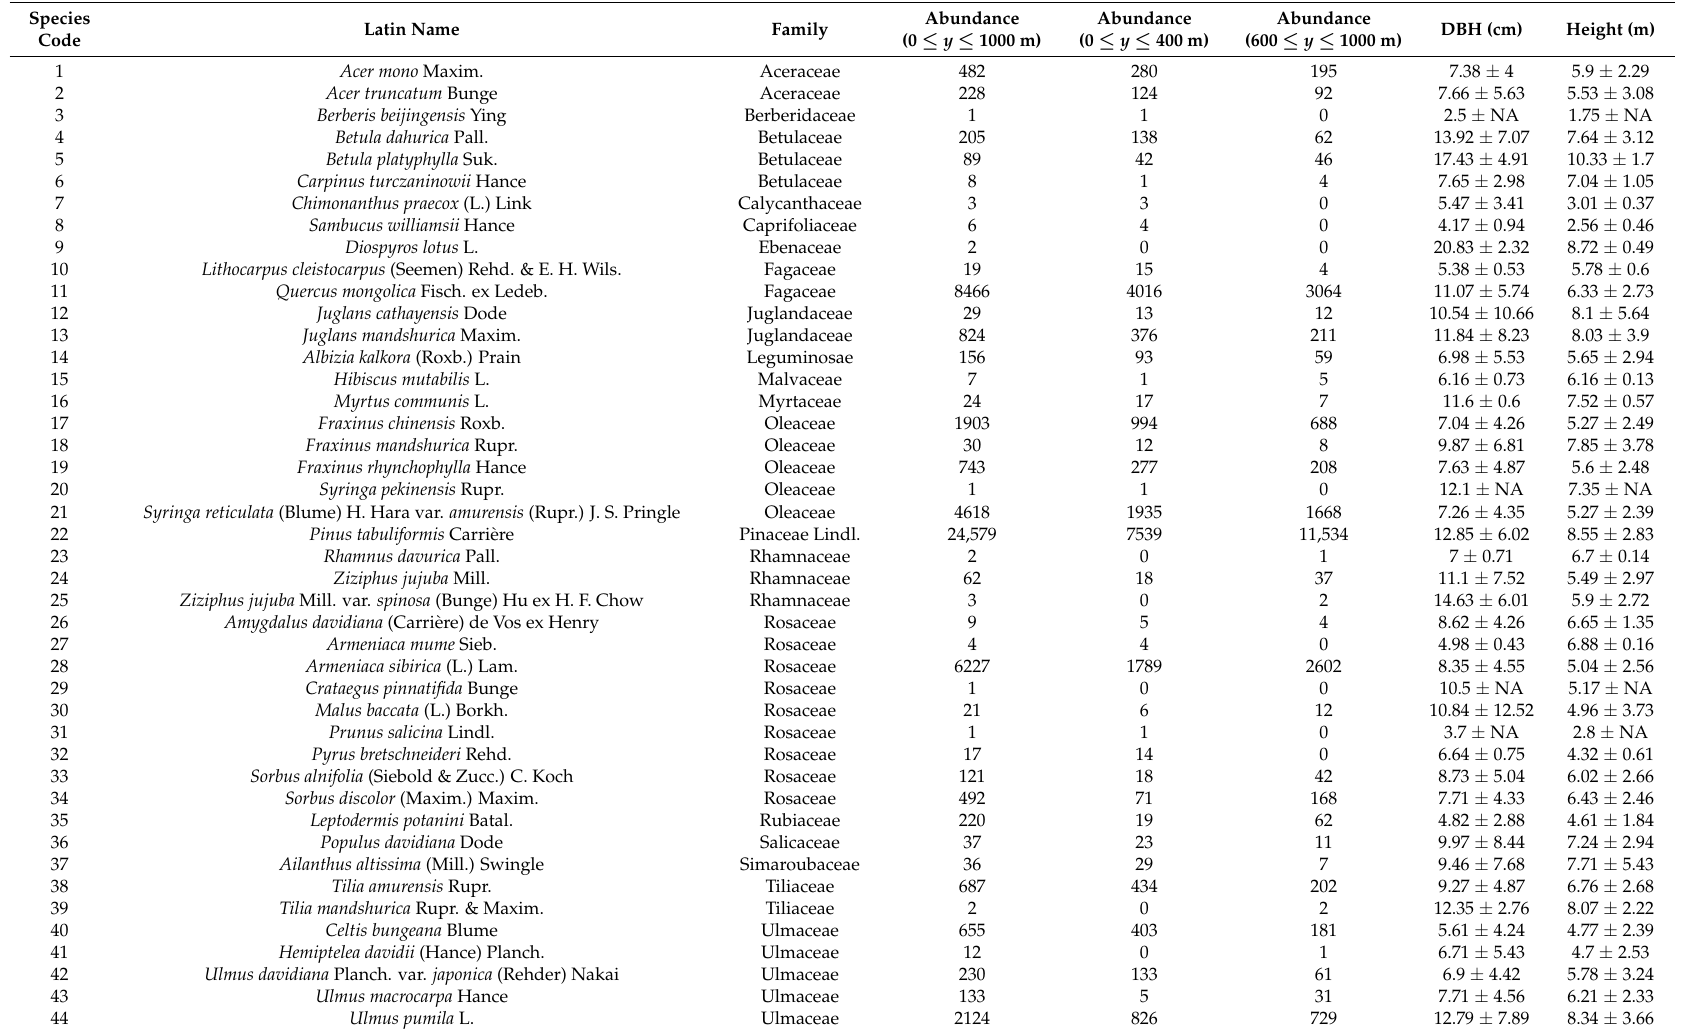
Table 1. List of tree species in the study region [0, 400] × [0, 1000] (unit: m). y denotes the y -axis coordinate of the study region; NA denotes no value. Species